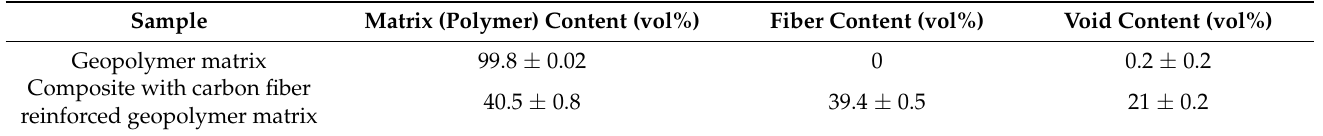
Table 2. Matrix, fiber, and void content of geopolymer matrix and composite.